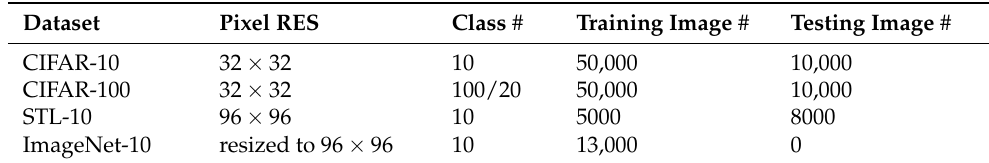
Table 1. Basic information of CIFAR-10/100, SLT-10, and ImageNet-10. Dataset Pixel RES Class # Training Image # Testing Image